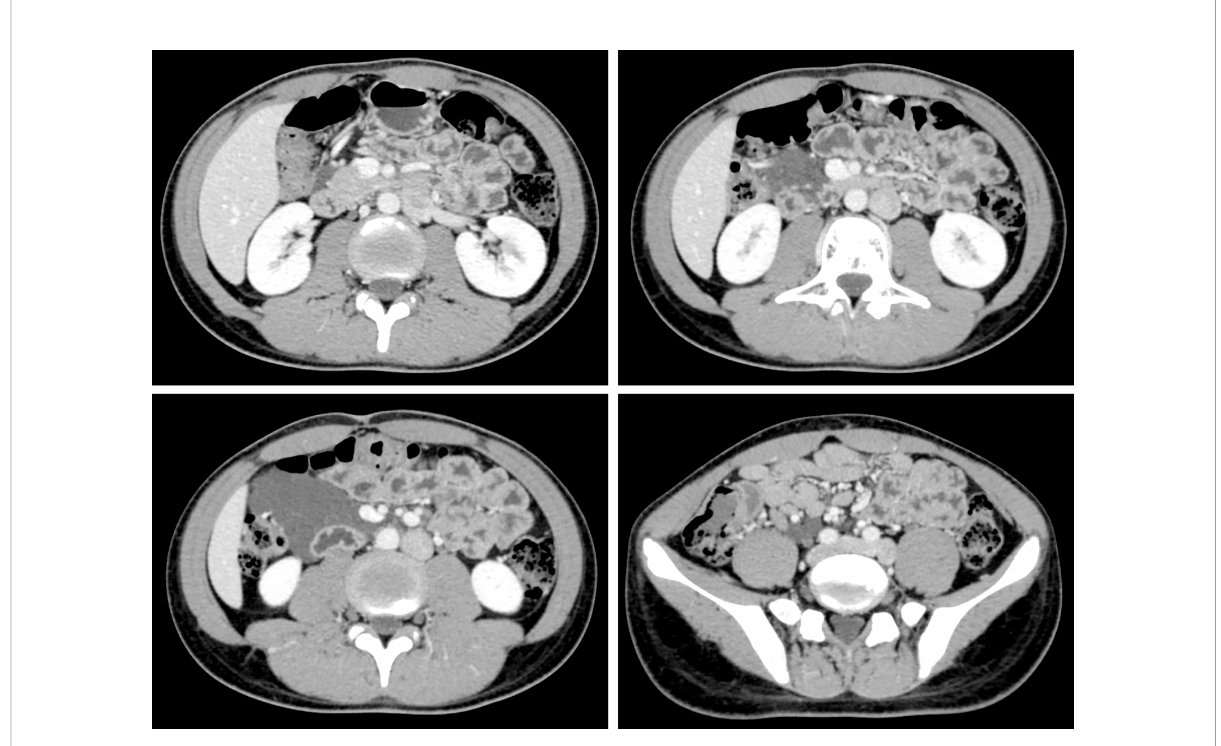
FIGURE 1 Computed tomography showed a large cystic